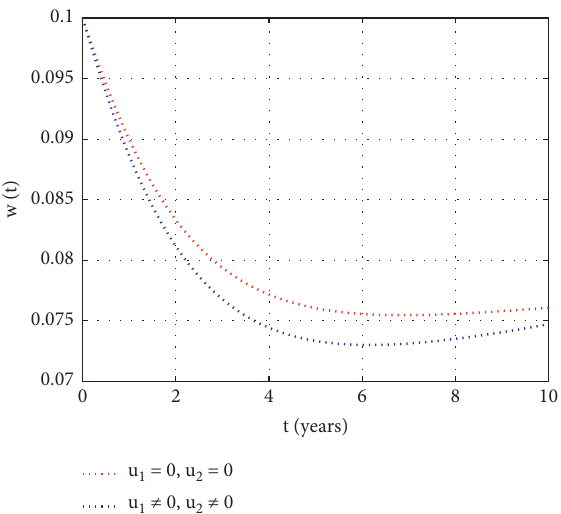
Figure 5: Simulation of window population size without and with controls.